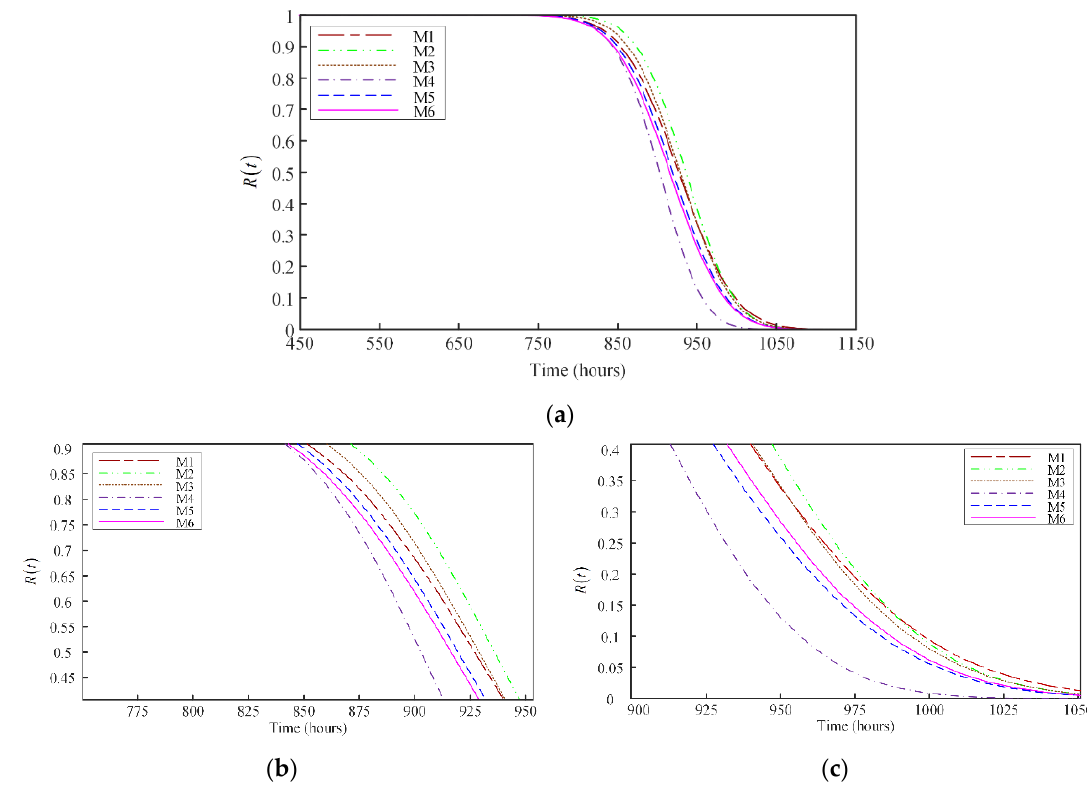
Figure 13. Reliability estimation results for mechanical seals ( a ) Reliability comparison for six different models; ( b ) Local enlargement in the period of 775–950 h; ( c ) Local enlargement in the period of 900–1050 h. Table 8. Comparisons of the MTTF for different reliability estimation